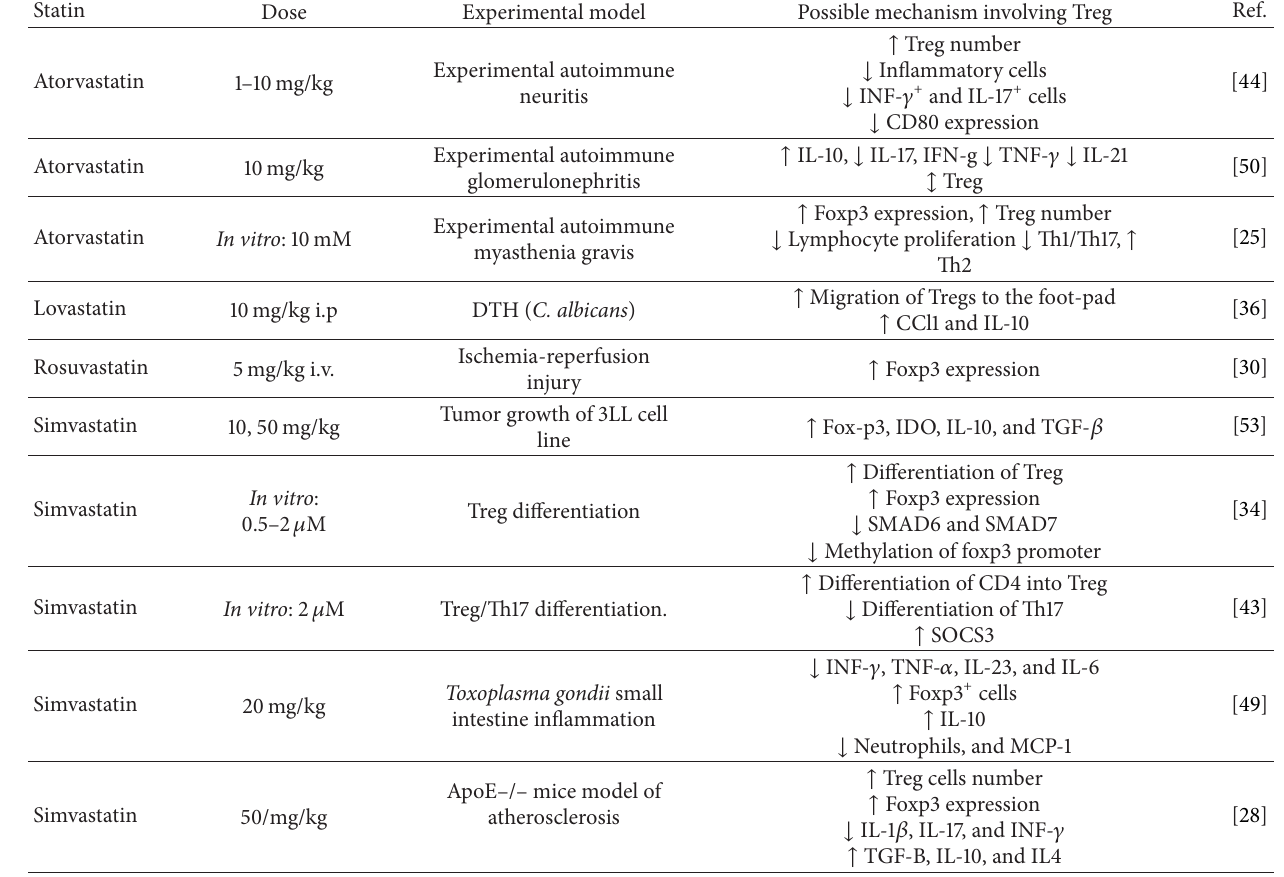
Table 1: Lines of evidence on the modulation of regulatory T cells by statins in